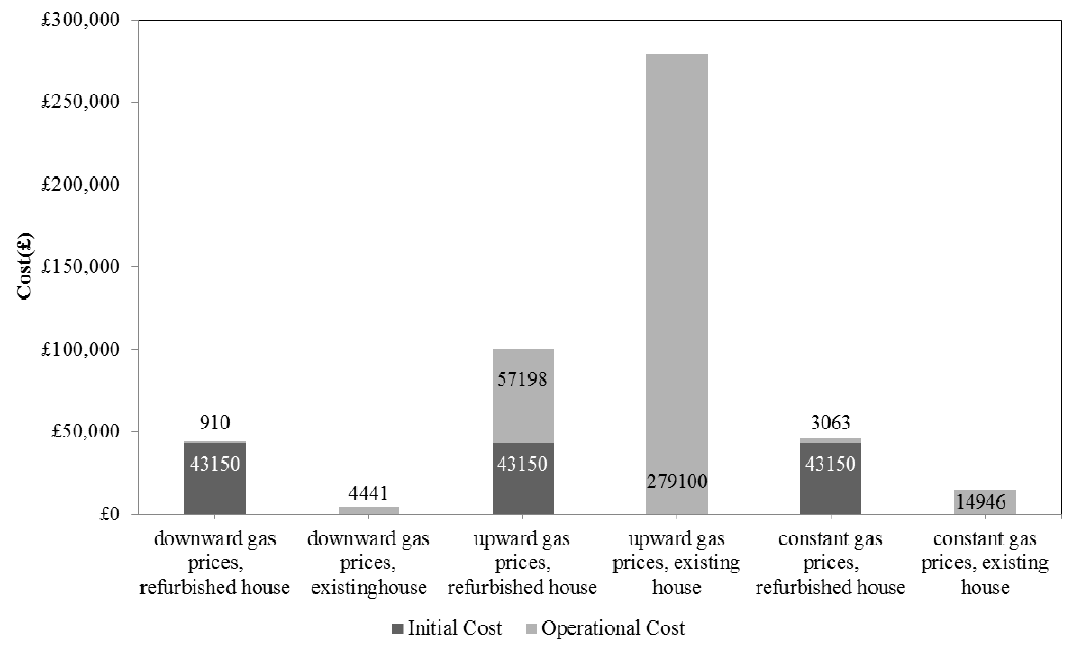
Figure 15. Whole Life Cycle Cost (WLCC) of the post and pre refurbished house for current and future Edinburgh weather data over 40 years for different gas price